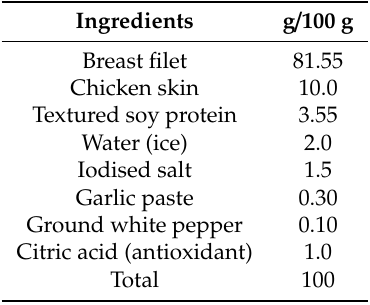
Table 1. Formulation used in the elaboration of hamburgers produced with chicken breast without myopathies and a ff ected by wooden breast